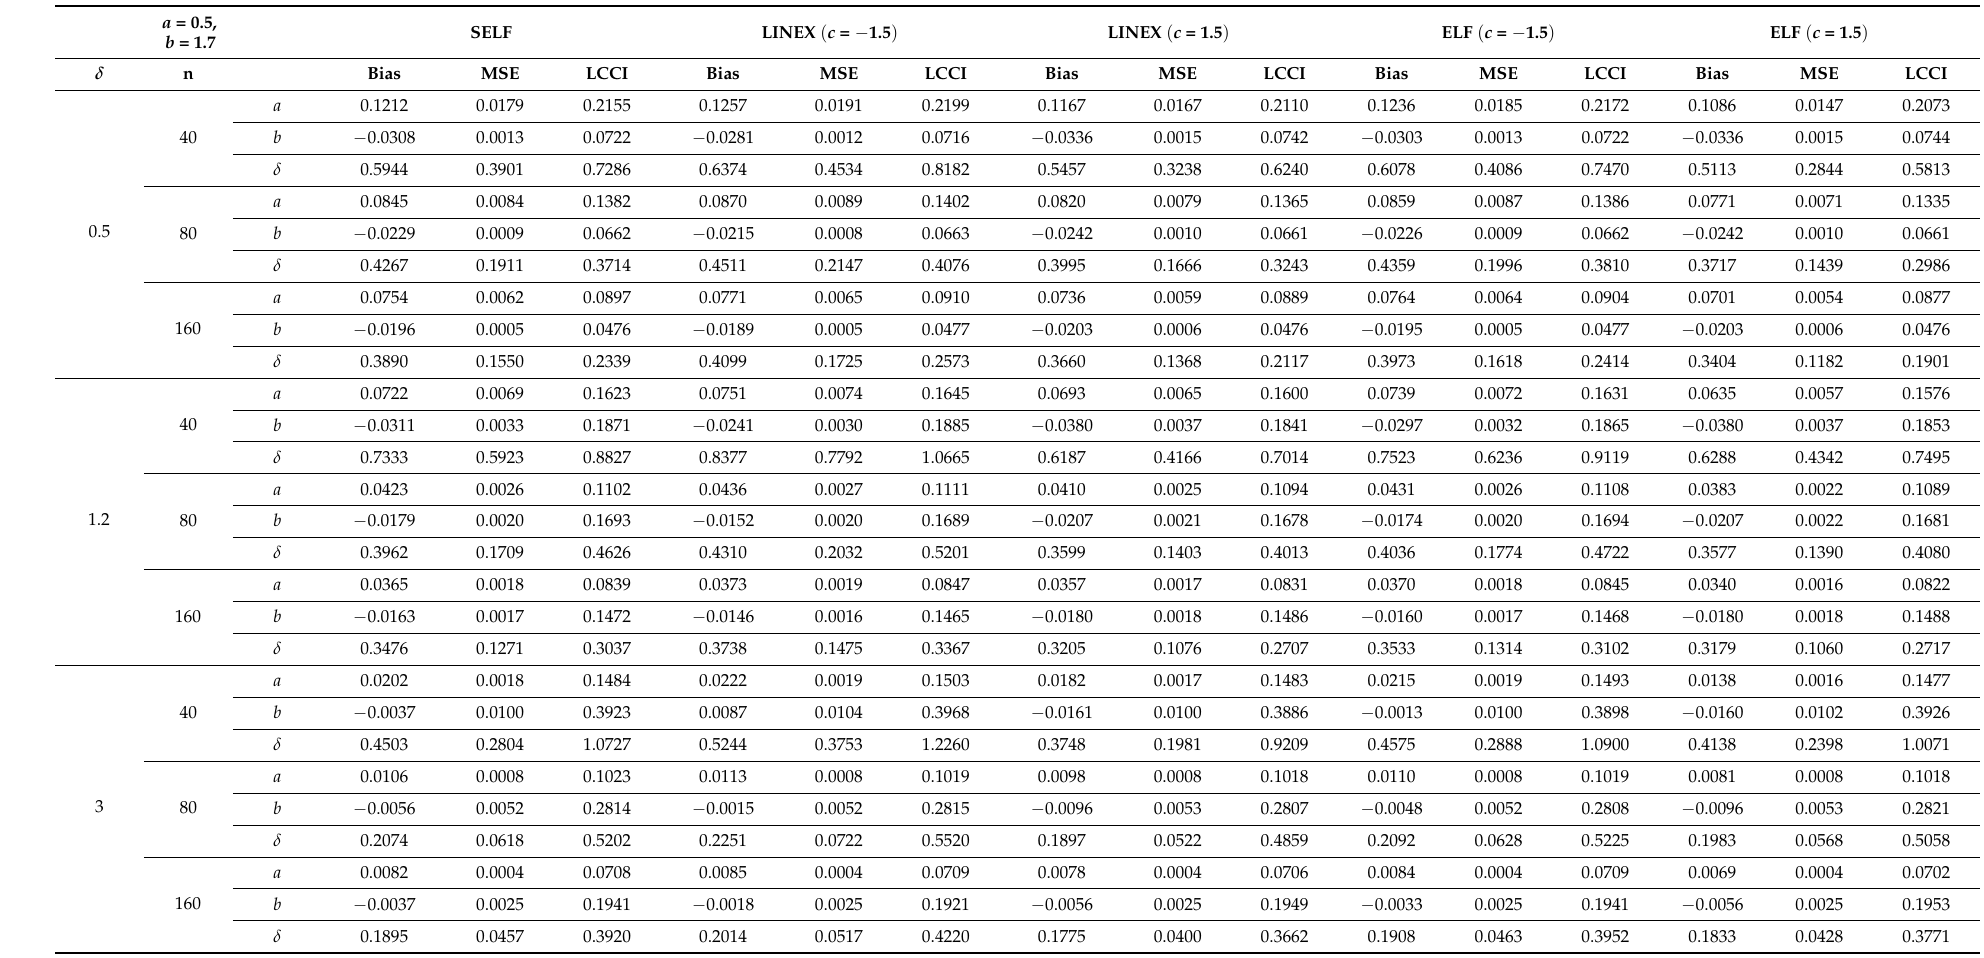
Table 4. Bayesian inference with different loss functions when a = 0.5, b =